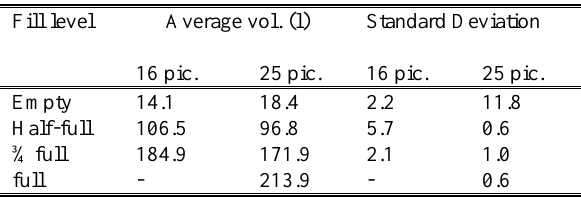
Table 3: Average values and standard deviations for 20 measurements with 16 and 25 images for different filling levels